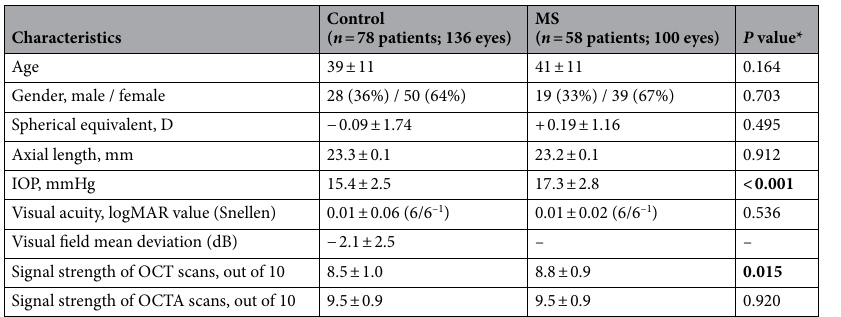
Table 1. Characteristics of participants by disease status. Data presented are mean (SD) or number (%), as appropriate. IOP intraocular pressure, OCT optical coherence tomography, OCTA optical coherence tomography angiography. Significant values are in bold. * P value was obtained with Kruskal–Wallis test for non-normally distributed continuous variables, independent t-test for normally distributed continuous variables, and chi-square or Fisher’s exact tests for categorical variables.